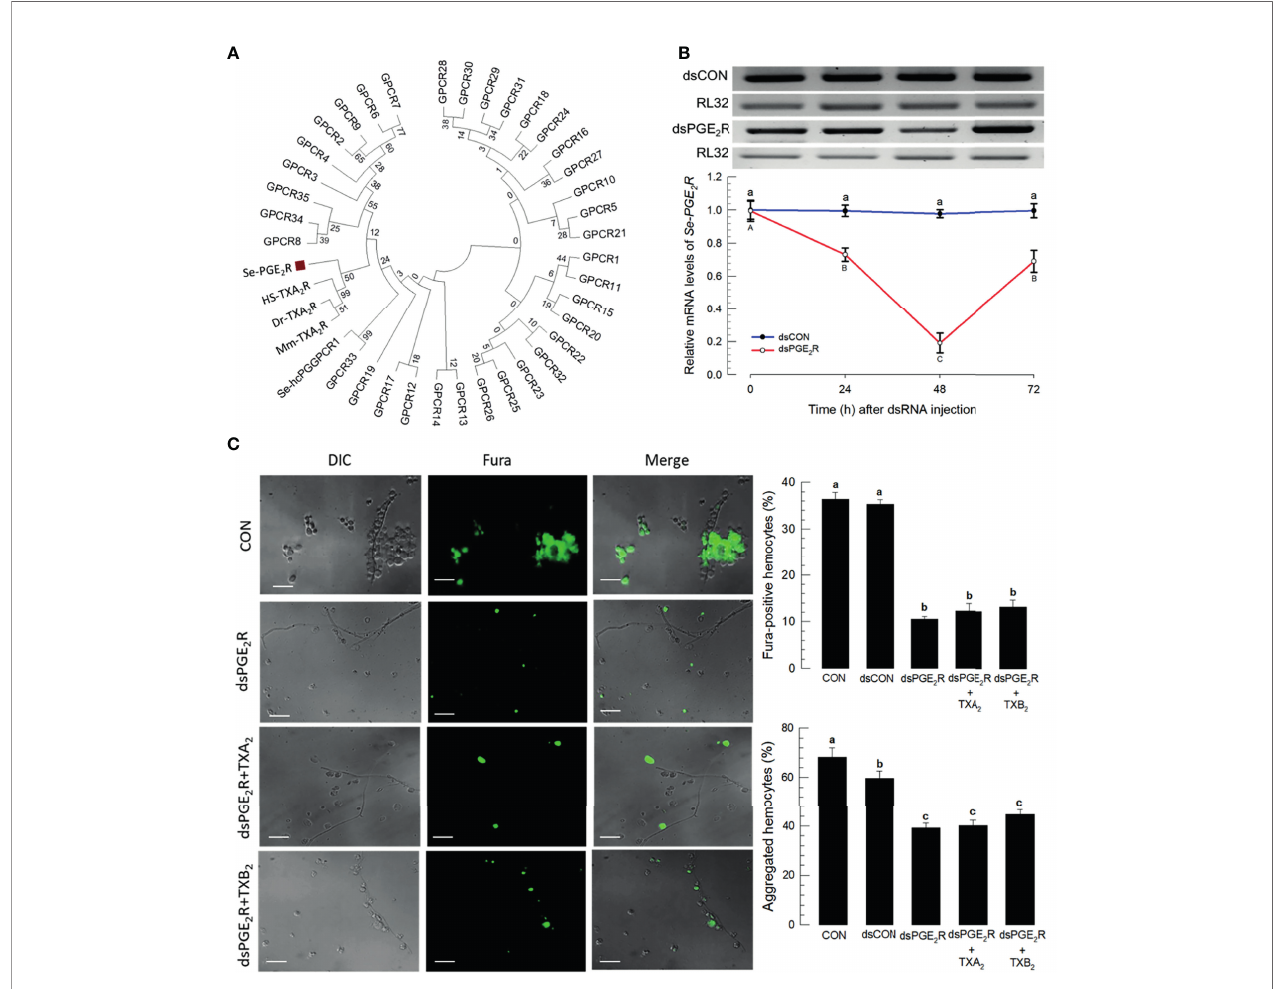
FIGURE 7 | A PGE 2 receptor mediates thromboxane signaling in S . exigua . Panel (A) shows a phylogenetic analysis of 35 S. exigua G-protein coupled receptors (GPCRs) indicating two PGE 2 receptors ( ‘ Se-PGE 2 R ’ and Se-hcPGGPCR1 ’ ). The Se receptors are closely aligned with human ( ‘ Hs ’ ), mouse ( ‘ Mm ’ ), and fi sh ( ‘ Dr ’ ) TXA 2 receptors ( ‘ TXA 2 R ’ ) using the Neighbor-Joining method with MEGA6.06. GenBank accession numbers of these genes are presented in Supplementary data ( Table S4 ). Bootstrap values on the branches were estimated with 1,000 repetitions. The black square indicates a clustering with vertebrate TXA 2 Rs. Panel (B) indicates the in fl uence of a dsPGE2R construct on accumulations of mRNAs encoding Se-PGE 2 R as a function of time post-injections. Control dsRNA ( ‘ dsCON ’ ) used dsRNA speci fi c to GFP . Panel (C) shows the in fl uence of dsPGE2R on Ca 2+ signaling and hemocyte aggregation, which was not reversed after co-injection of dsPGE2R+TXA 2 and dsPGE2R+TXB 2 . ‘ DIC ’ represents differential interference contrast. ‘ CON ’ represents the fungal infection alone. Each treatment was replicated three times. Data analyzed and presented as described in Methods . Different letters above standard deviation bars indicate signi fi cant difference among means at Type I error = 0.05 (LSD